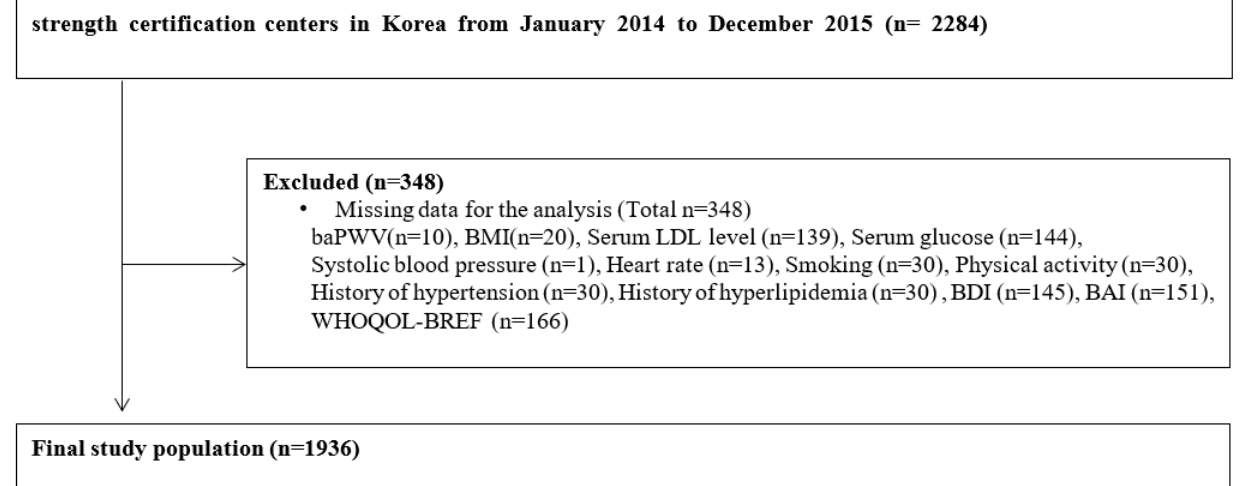
Figure 1. Flow diagram of study participants. Abbreviations: baPWV, brachial-ankle pulse wave velocity; BMI, body mass index; LDL, low density lipoprotein cholesterol; BDI, Beck’s depression inventory; BAI, Beck’s anxiety symptoms index; WHOQOL-Bref, World Health Organization’s Quality of Life Questionnaire.